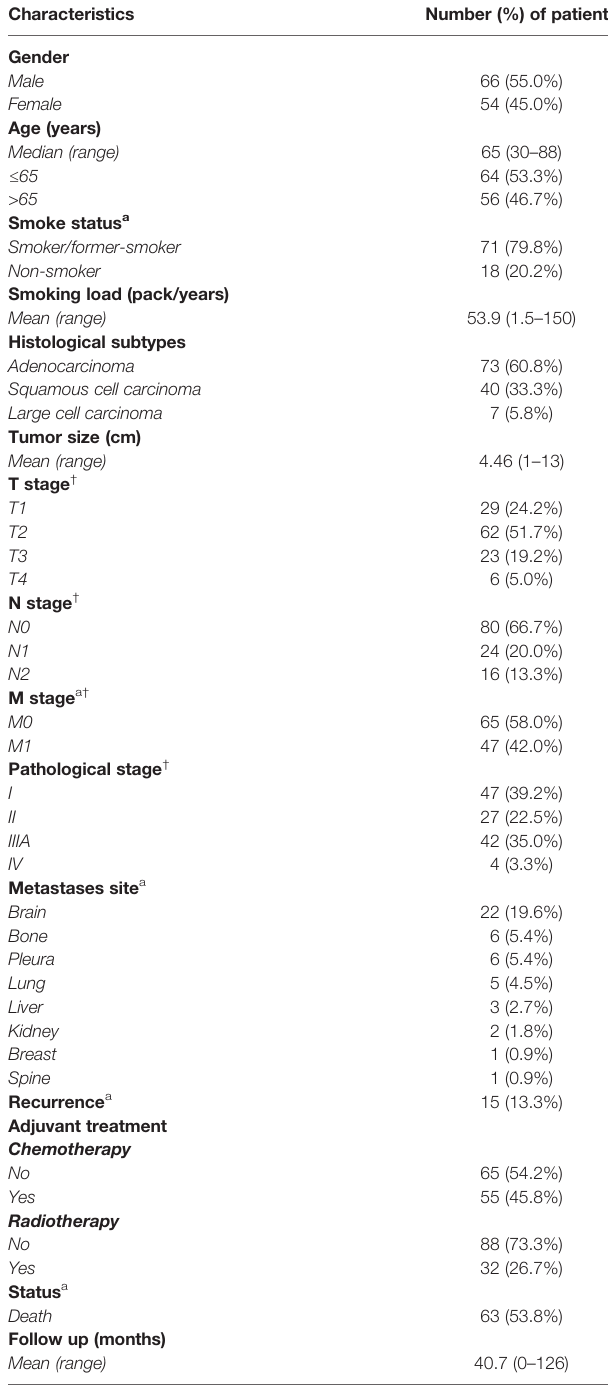
TABLE 1 | Demographic and clinicopathologic characteristics of the patients (N =